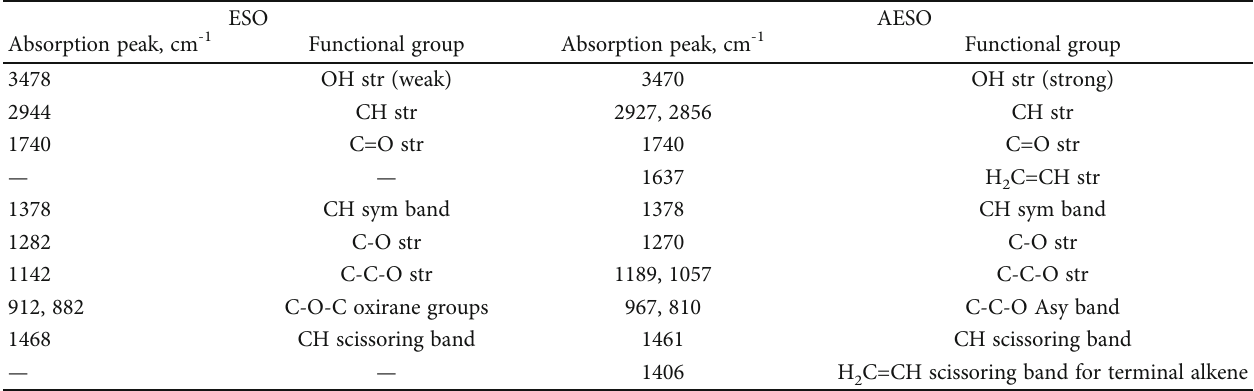
Table 4: Important parameters for acrylation of epoxidized palm olein/oil [40, 41, 48 –